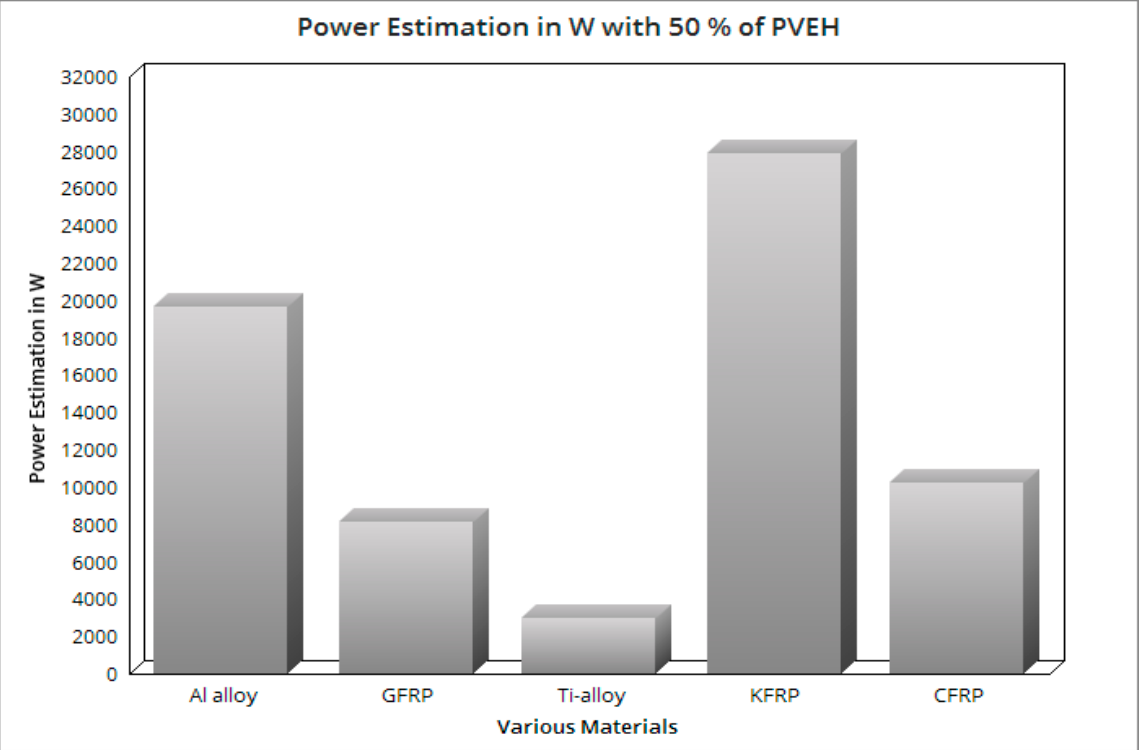
Figure 36. Power (P 0 ) in W with 75% attachment coverage—wind turbine blade.